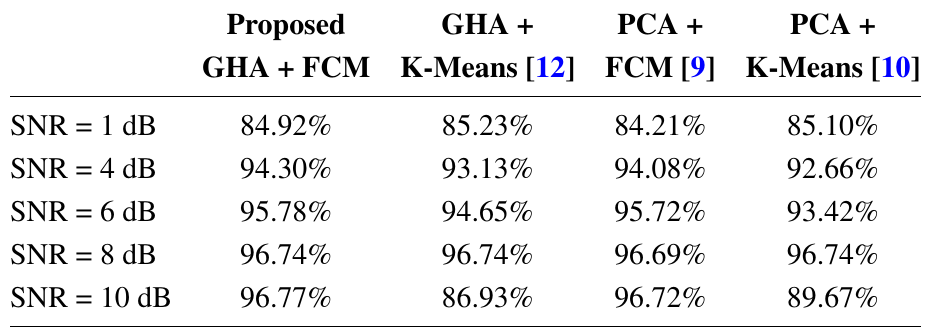
Table 9. CCR values of various spike sorting algorithms.